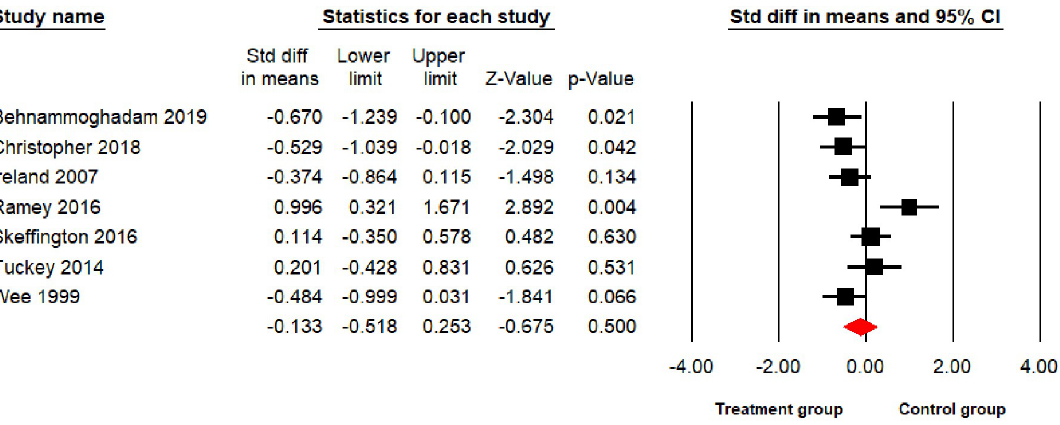
Fig 5. Forest plot for the effect of interventions on stress